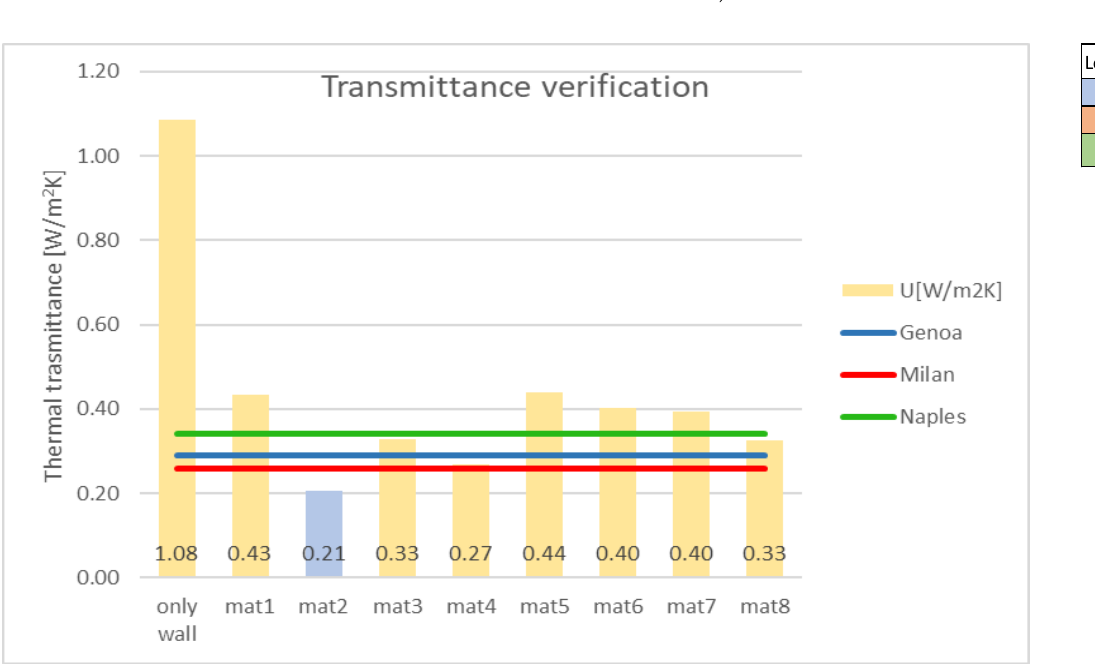
Figure 4. Thermal transmittance in cavity walls with different heat reflective insulating layers (application in the middle of the air cavity). The red, blue, and green lines represent the threshold for different cities.